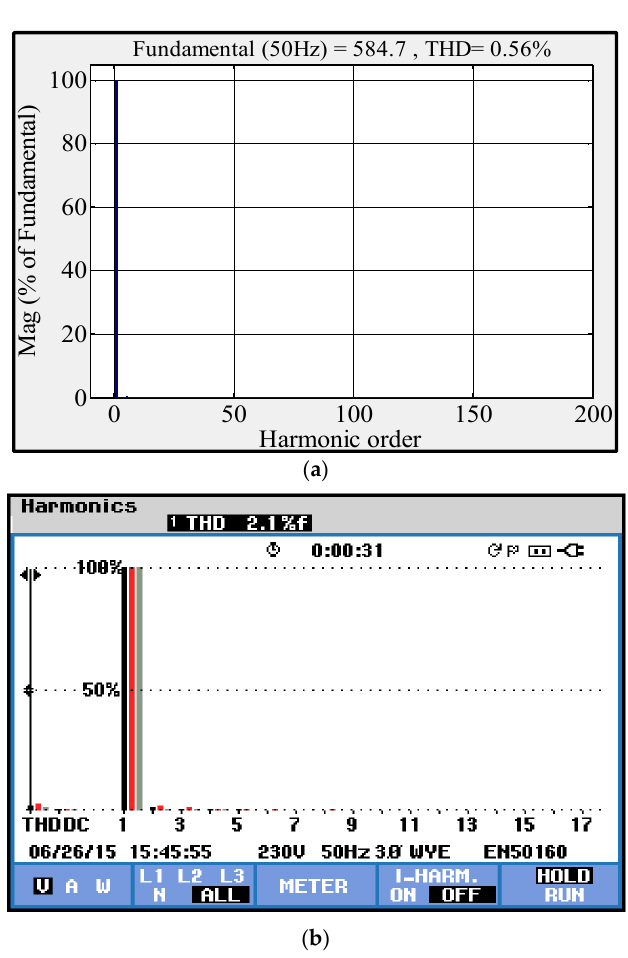
Figure 16. THD for the phase voltage of the three-phase inverter with R load for ( a ) simulation and ( b ) experimental.